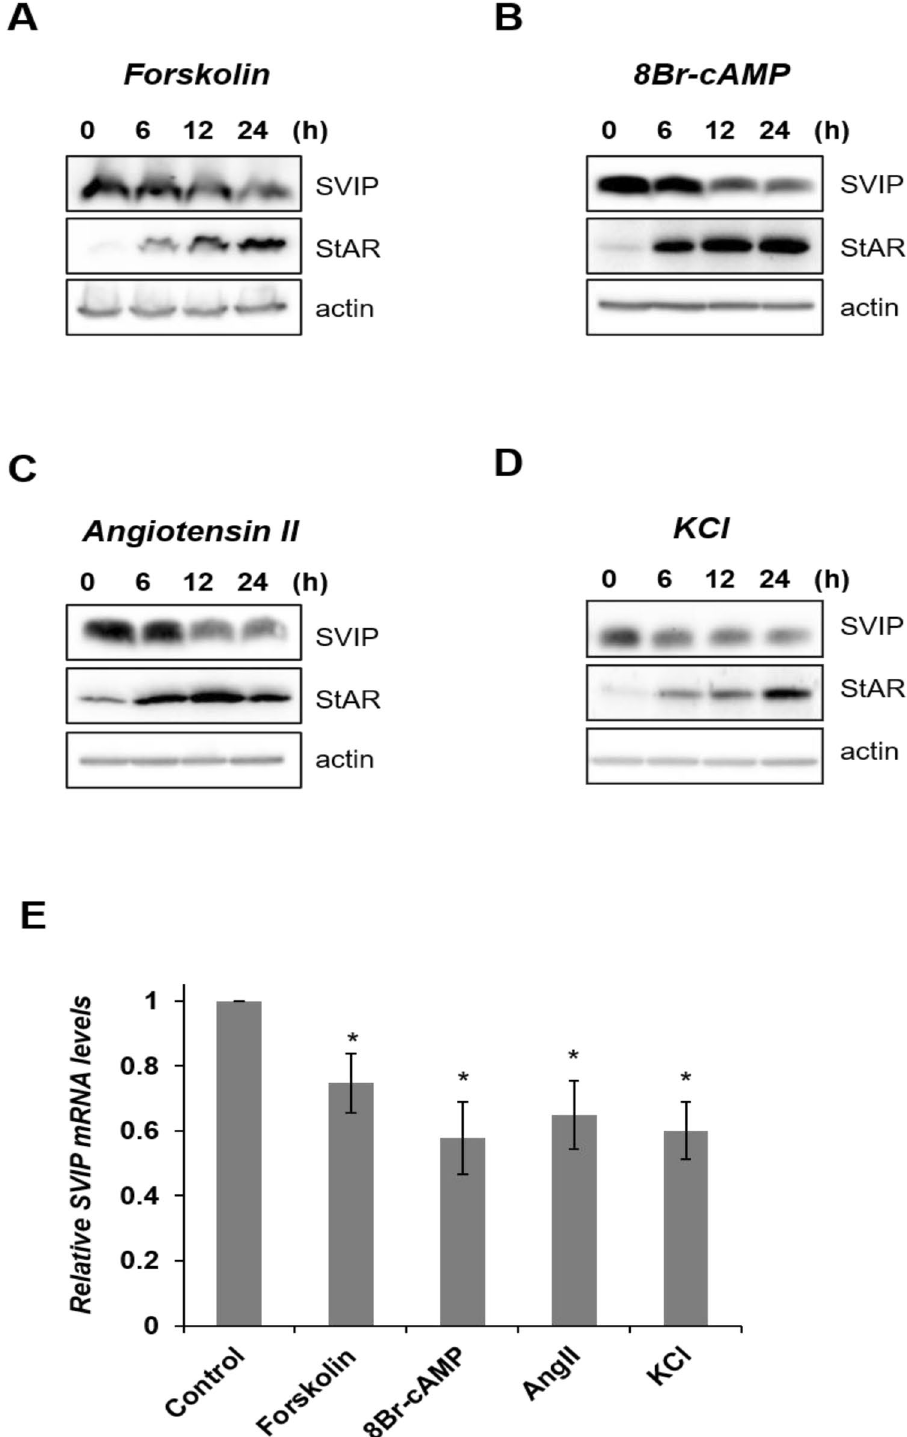
Figure 5. Stimulation of steroidogenesis downregulates SVIP. H295R cells were treated with ( A ) 10 μM forskolin, ( B ) 0.5 mM 8Br-cAMP, ( C ) 0.1 μM angiotensin II or ( D ) 14 mM KCl for the indicated times and SVIP protein levels were determined via immunoblotting (IB). Actin antibody was hybridized to the same membranes to verify equal protein loading. ( E ) SVIP mRNA was quantified by RT-qPCR. The experiment was repeated twice with at least three replicates. Error bars represent standard error (*p < 0.05). ( F ) The degradation of SVIP was analyzed by cycloheximide (CHX) chase on forskolin or vehicle-treated H295R cells. The SVIP and StAR levels were determined via IB (l.e.: longer exposure). Densitometric analysis of SVIP levels by ImageQuant is shown in the right panel (mean ± S.D., n = 3) (*p < 0.05 and **p < 0.01) ( G ) Following treatment with forskolin for the indicated times, expression levels of gp78, p97/VCP, SVIP, and StAR were detected by IB using antibodies against them. Actin was used as a loading